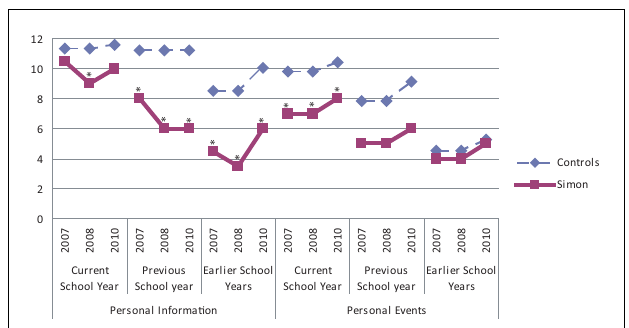
FIGURE 1 | Production of personal information and events across the three lifetime periods. * p <0.05. Legend: Simon’s scores were compared with those of controls matched on chronological age and published in Piolino et al. (2007). Simon obtained pathological scores ( Z < 1.777; p < 0.05; df=13) for personal information for the previous school year and earlier school years, as well as for the current school year, though only in 2008. Personal event scores were only pathological for the current school year period, although they were slightly low for the previous school